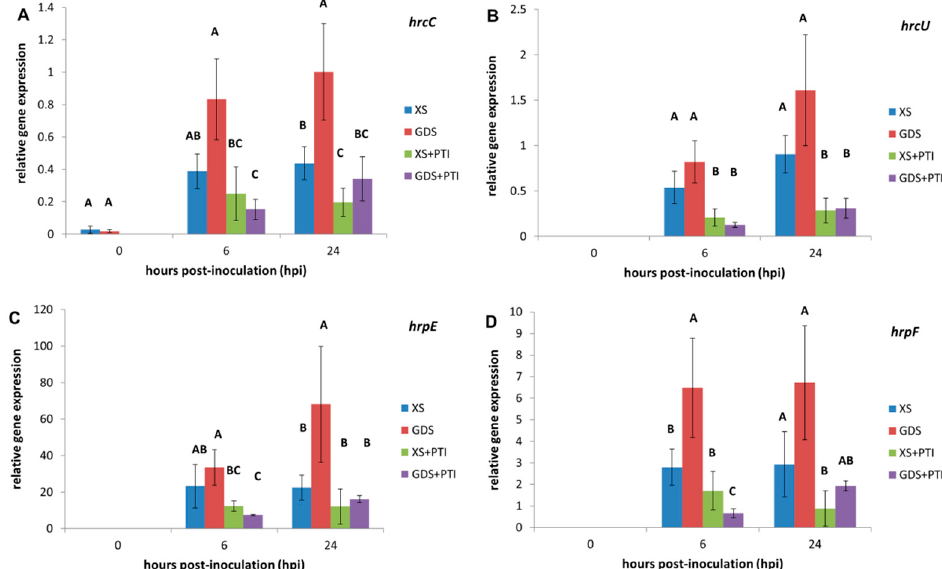
Figure 4. In planta expression of the T3SS structural genes of X. euvesicatoria as affected by PTI and GDS: ( A ) hrcC; ( B ) hrcU; ( C ) hrpE; ( D ) hrpF . At 0 hpi, the plant leaves were injected with 10 8 cell ml − 1 X. euvesicatoria . PTI was initiated 24 h prior to X. euvesicatoria inoculation by injecting the same leaves with heat-killed P. syringae 61 hrcC . Leaf samples were taken at the indicated time points after X. euvesicatoria infections. To determine the relative gene expression, the measured target gene Ct values were normalized to those of the reference genes ( atpD and rpoB ), and the two relative gene expression values were averaged. Bars represent the mean ± standard deviations of two replicates. The letters above the columns indicate significantly different groups for the values belonging to the given sampling time. XS: susceptible plant, GDS: gds gene-carrying resistant plant, +PTI: PTI activated in plant before X. euvesicatoria inoculation.